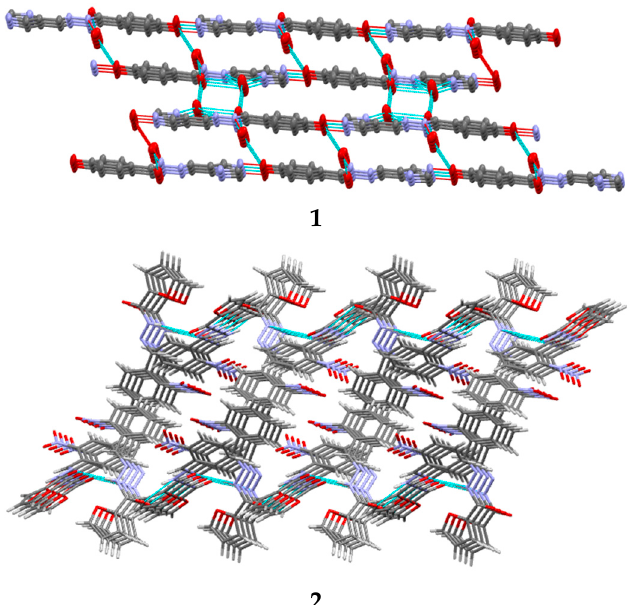
Figure 4. 2D-layered structure of Compound 1 and 3D network structure of Compound 2.